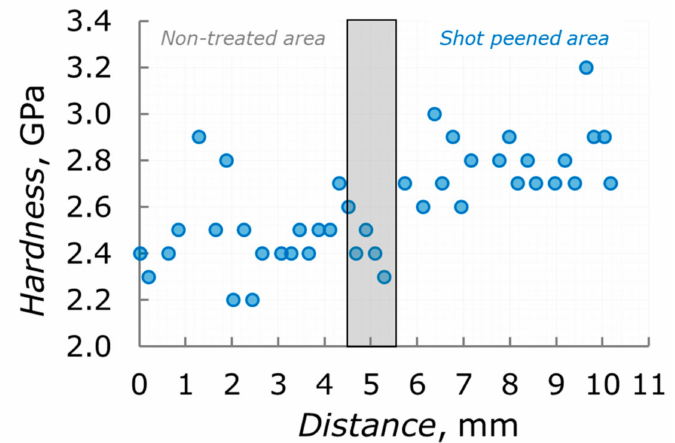
Figure 6. Hardness (blue circles) of VT6 alloy in the Transition zone sample.